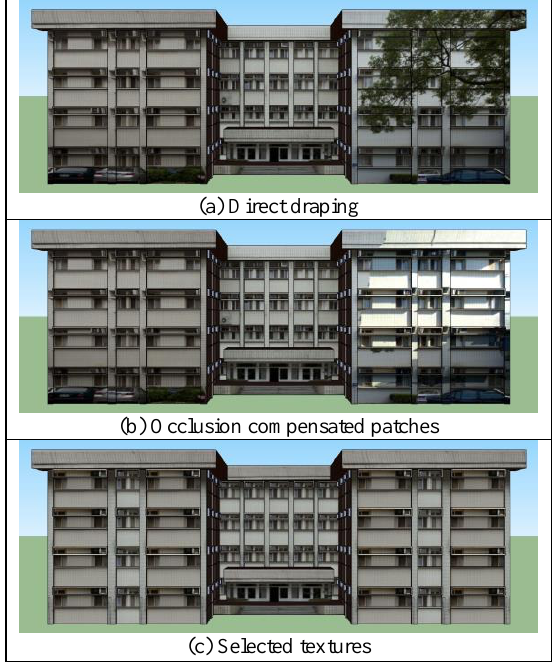
Figure 10. The Results of Texture